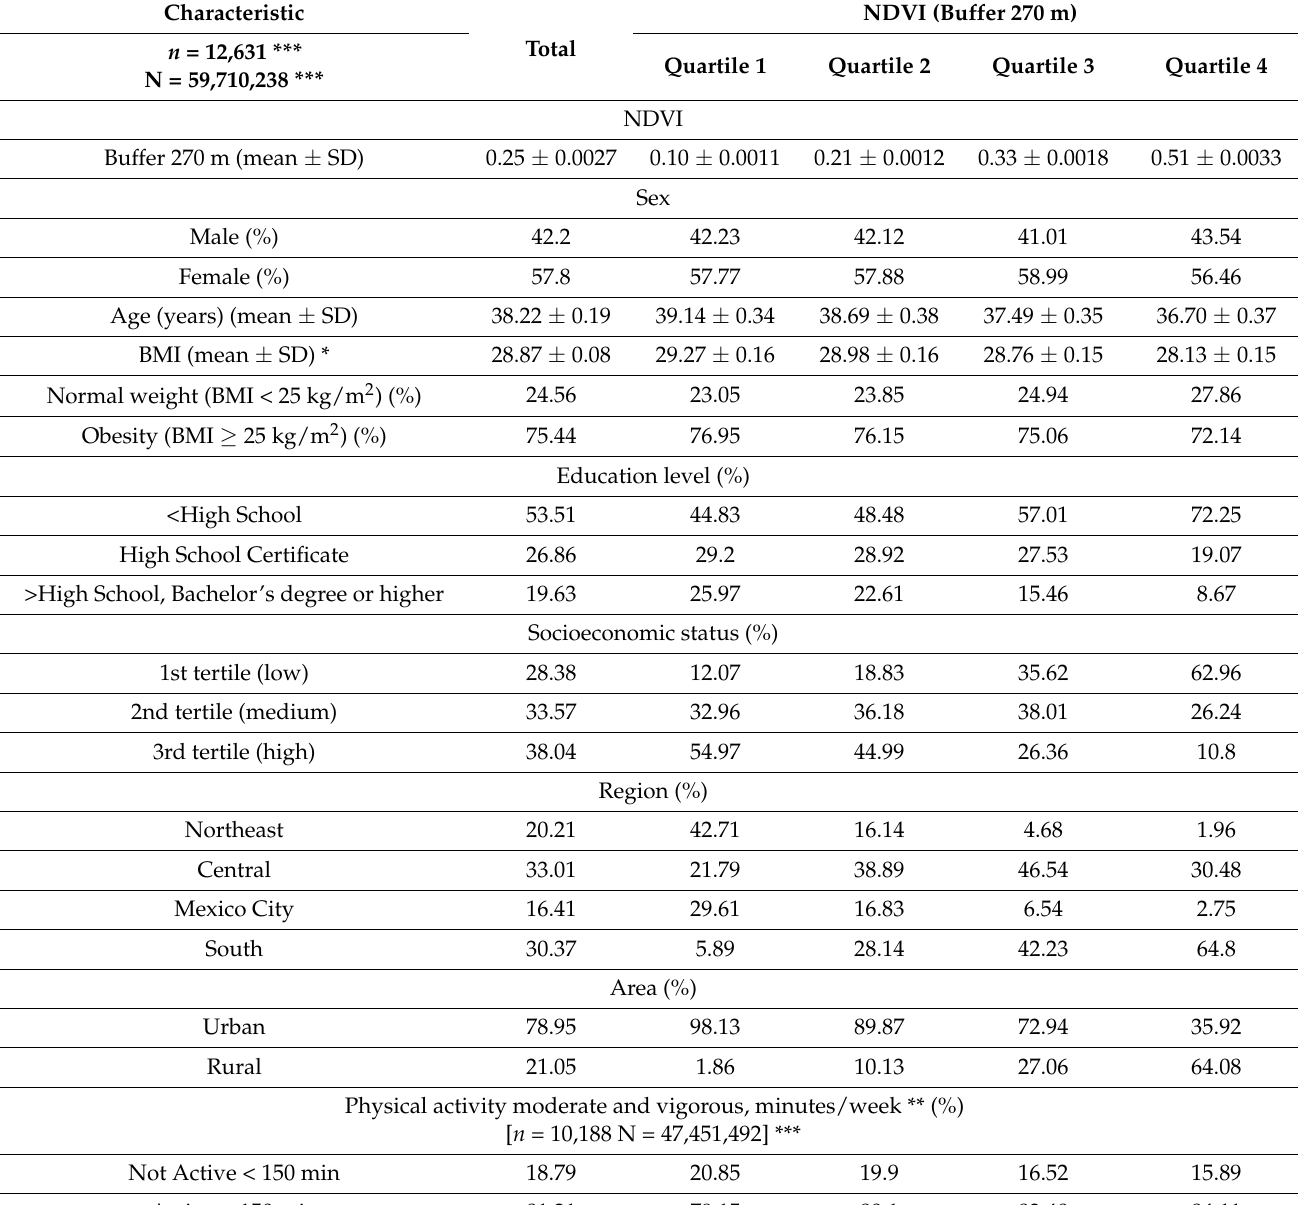
Table 1. Characteristic sociodemographic of the Mexican adults population aged 20 to 59 participants in ENSANUT 2018–2019, by quartiles of NDVI (buffer 270